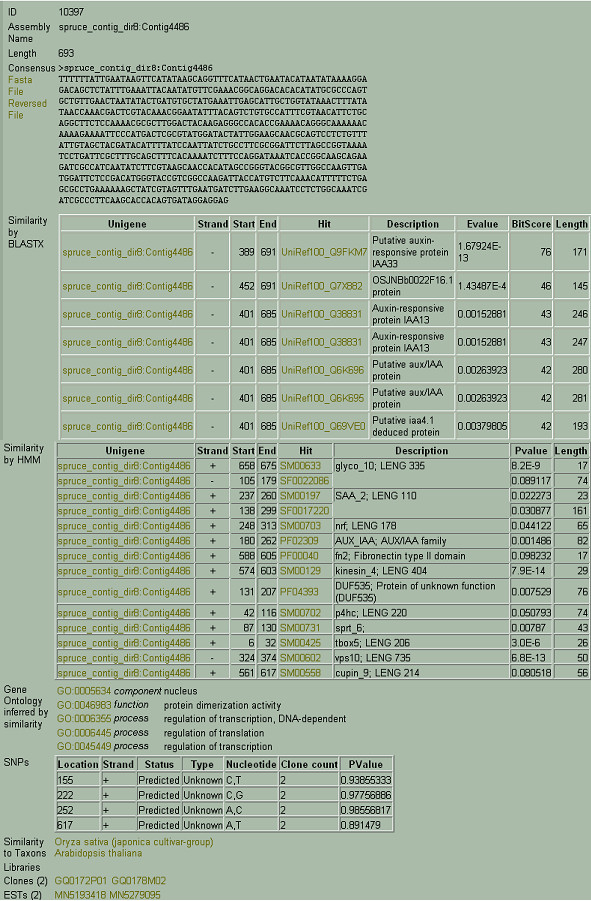
ForestTreeDB screenshot showing the result from a query based on the Contig4486 (ID: 10387). This page displays the Gene Ontology terms associated to the contig and SNP data and the similarity data obtained by Hidden Markov Model searches against the domains and families available in the PFAM  and SMART  database. A SNP table displays four SNPs predicted by PolyBayes in Contig4486, with PSNP scores ranging from 0.89 to 0.98. Links also allow retrieval of the members (clones and ESTs) of the studied contig, their sequences, as well as the read alignment in a MSF format.